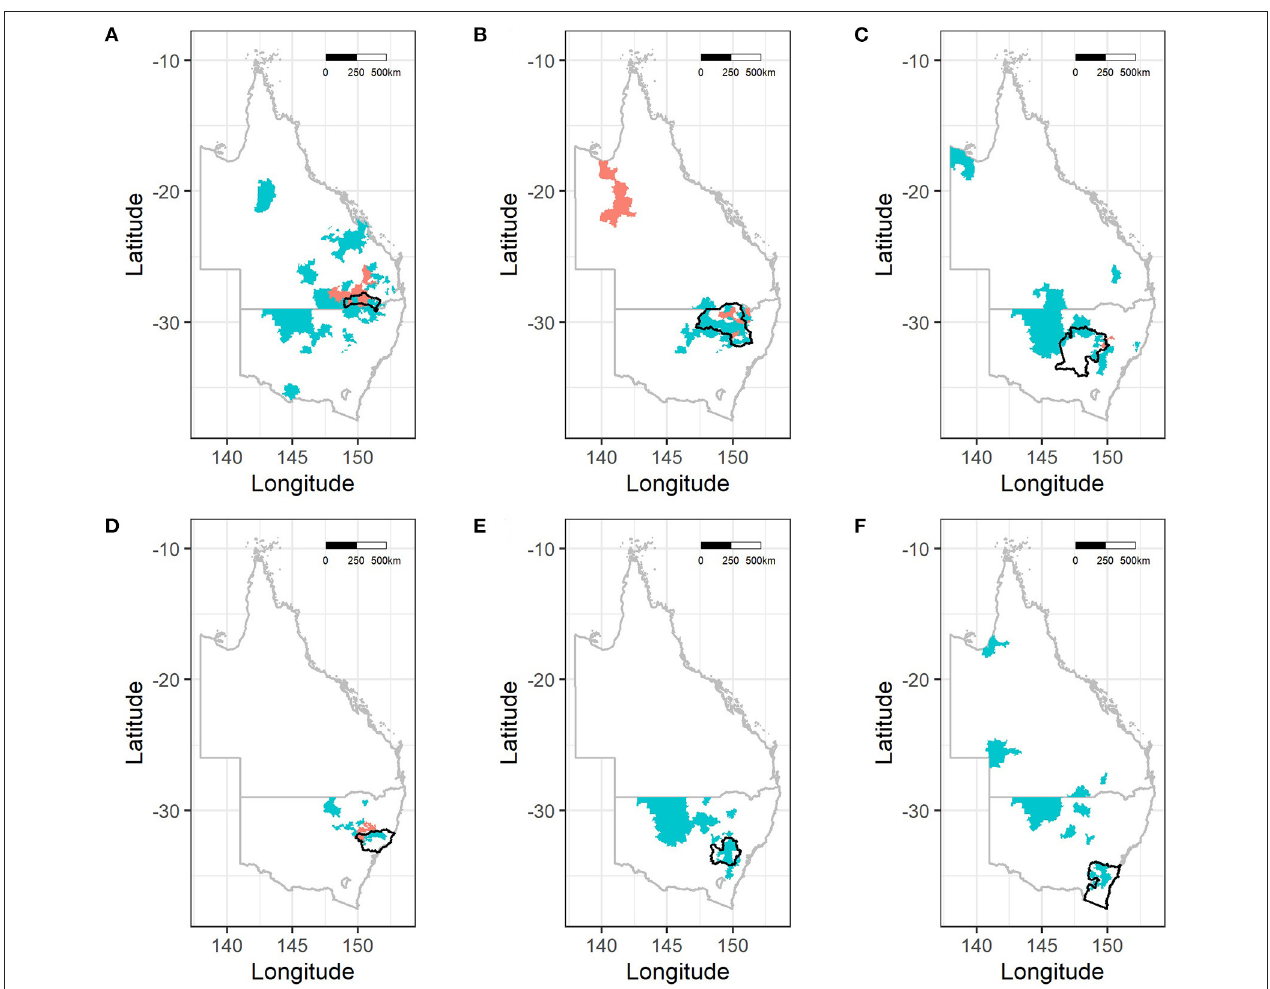
FIGURE 1 | Postcode areas frequented by dogs for hunting based on Local Land Services (LLS) region or Local Government Area (LGA) from which dogs originated. (A) Goondiwindi Region, (B) North West, (C) Central West, (D) Hunter, (E) Central Tablelands, and (F) South East. Note that number of dogs sampled per region and sizes of postcode areas varies. Postcodes shaded in coral represent areas where seropositive dogs hunted. Since dogs hunted in multiple areas that does not infer location where transmission/infection has occurred.